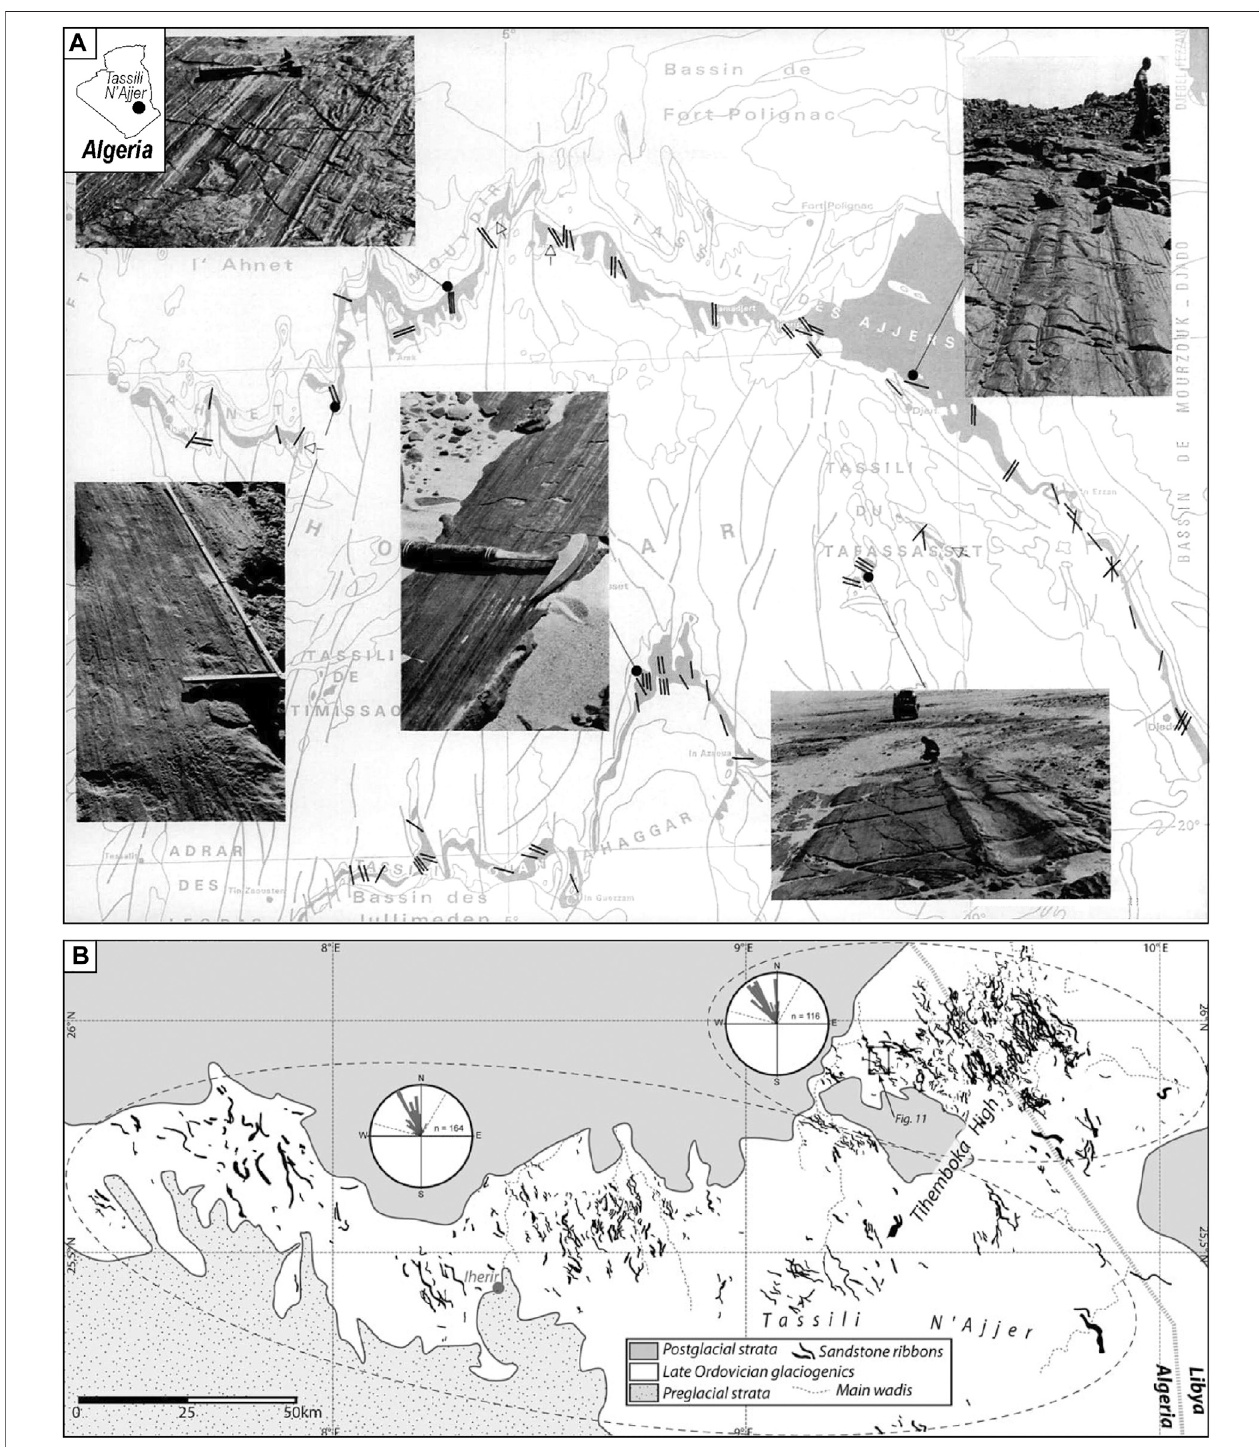
FIGURE 1 | Historical successes in capturing big picture glacial geomorphology in the ancient record. (A) The mapping efforts of Beuf et al. (1971) are a landmark achievement in the documentation of the Late Ordovician glacial record of southern Algeria. This map (reproduced with permission) shows the distribution of soft- sediment striated surfaces across the Tassili N ’ Ajjer (shown here as the Tassili des Ajjers) plateau (represented by simple, black parallel lines). These authors did substantial fi eldworkintheregion,andthephotosshow fi veseparateexamplesofthesesoft-sedimentstriatedsurfacesoverawidearea. (B) MappingintheTassili N ’ Ajjer 40 years later (Girardet al., 2012), with focus ofmeltwater structures(sandstone ribbons in this image). The impressive, dense networkof structures results from high fi delity aerial photograph and satellite image mapping made possible thanks to the undeformed nature of the substrate, the gently dipping plateau, and the lack of vegetation in the central Sahara. Reproduced with permission of the Geological Society of London.